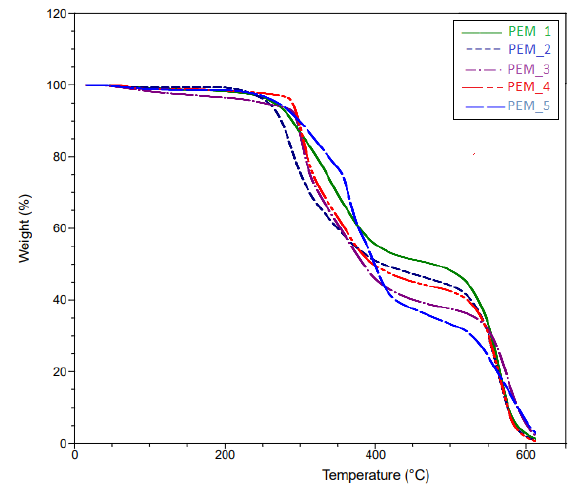
Figure 5. Thermal gravimetric analysis (TGA) curves of PEM_1–PEM_5.